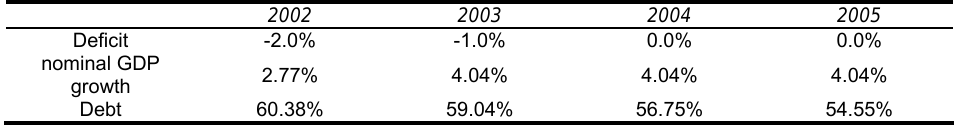
Table 2. German government deficit plan, starting in 2002, as submitted in December